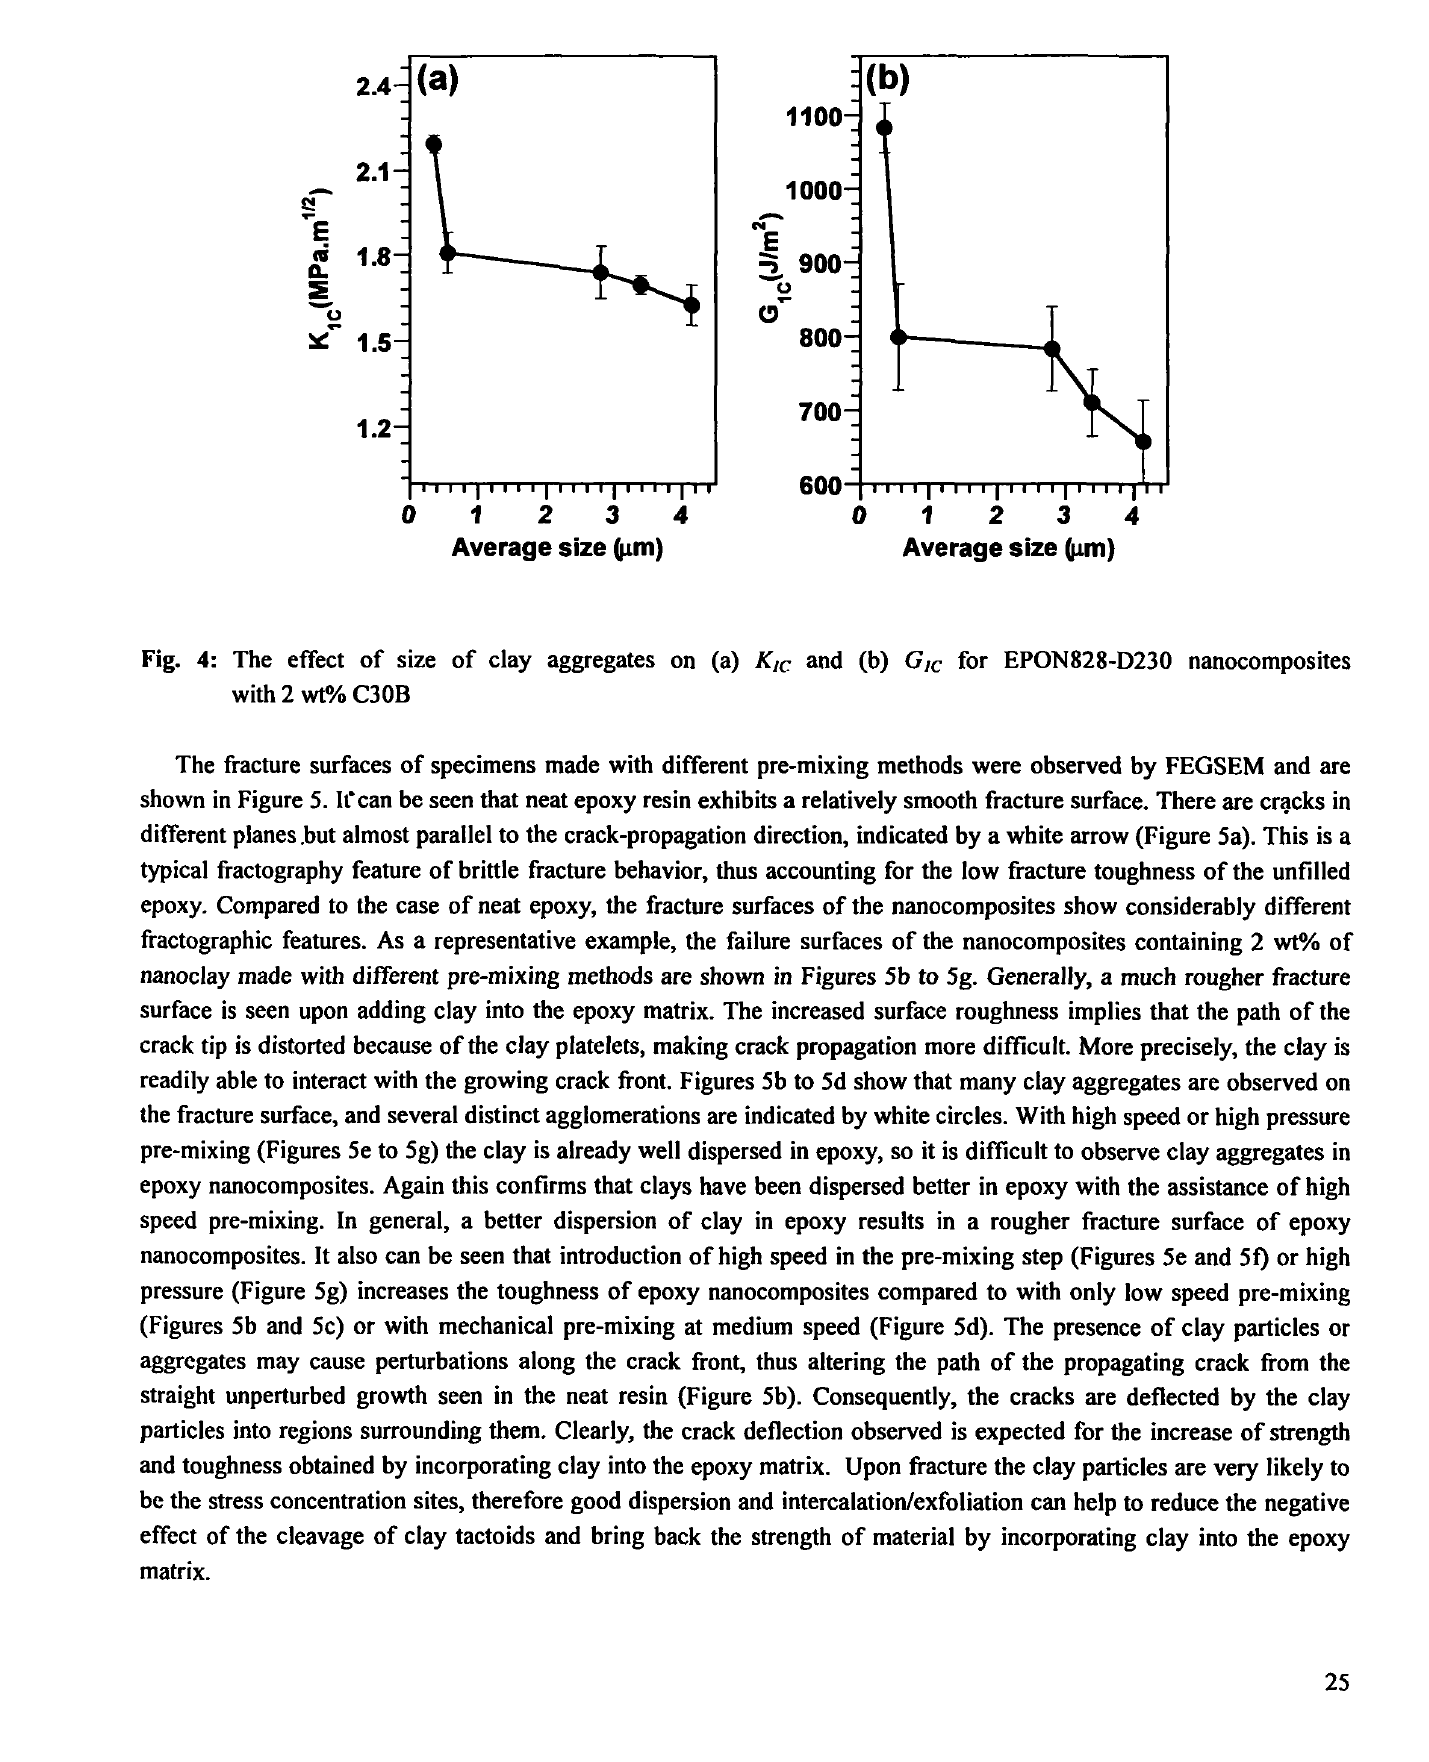
and (b) G/ for EPON828-D230 nanocomposites c c